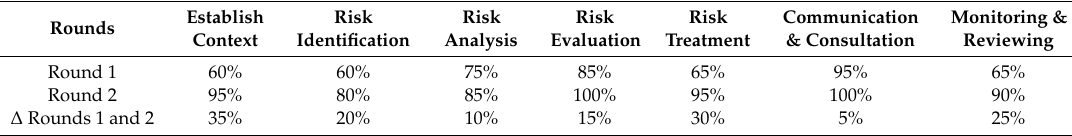
Table 1. Proportion of risk experts supporting the first- and second-cut plain English interpretations (PEIs).